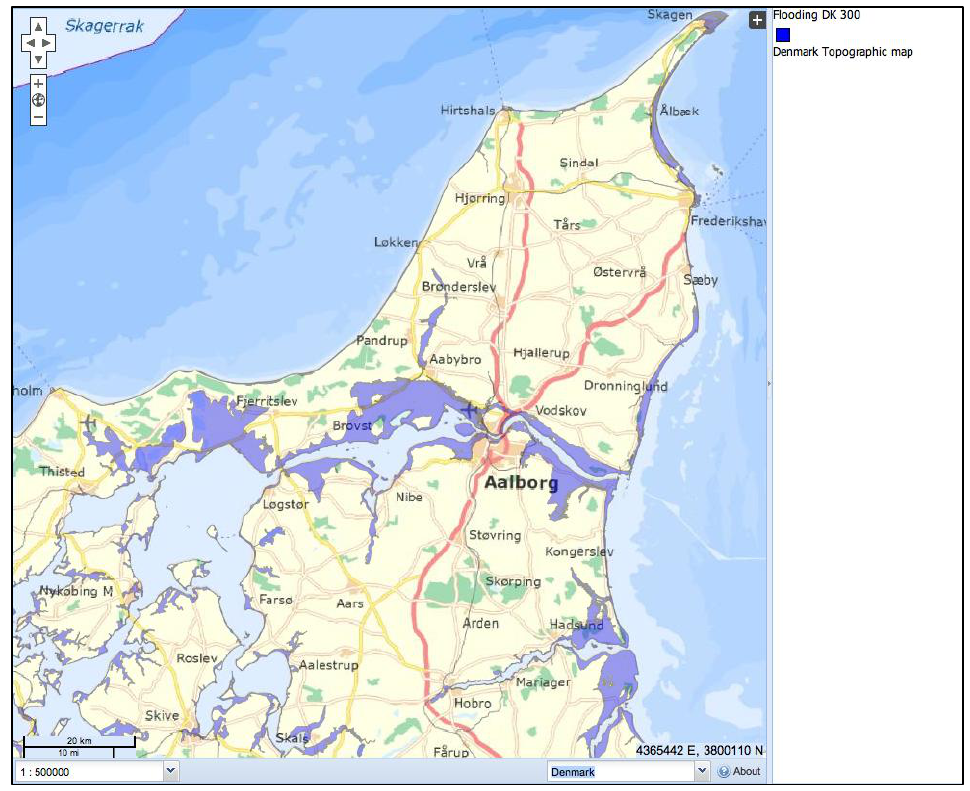
Figure 8. Indicator example—Extent of flooding due to combined effect of 100 cm sea-level rise and 150 cm storm surge.